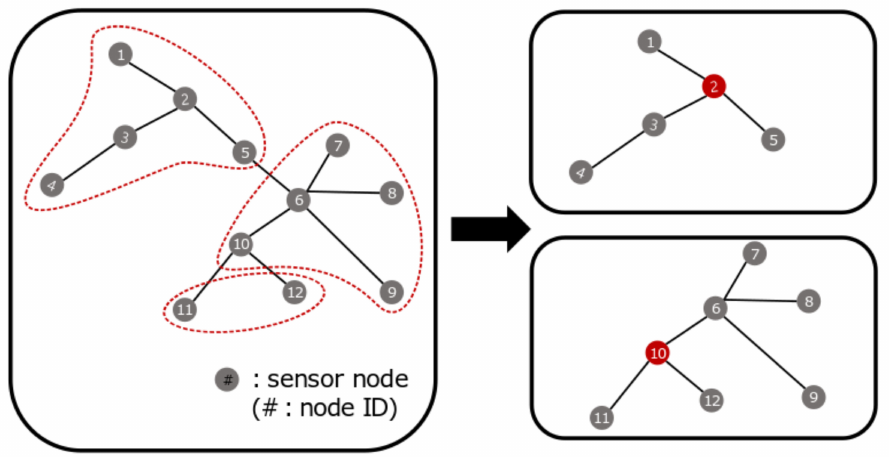
Figure 4. Division based on the cost function and optimal location of a